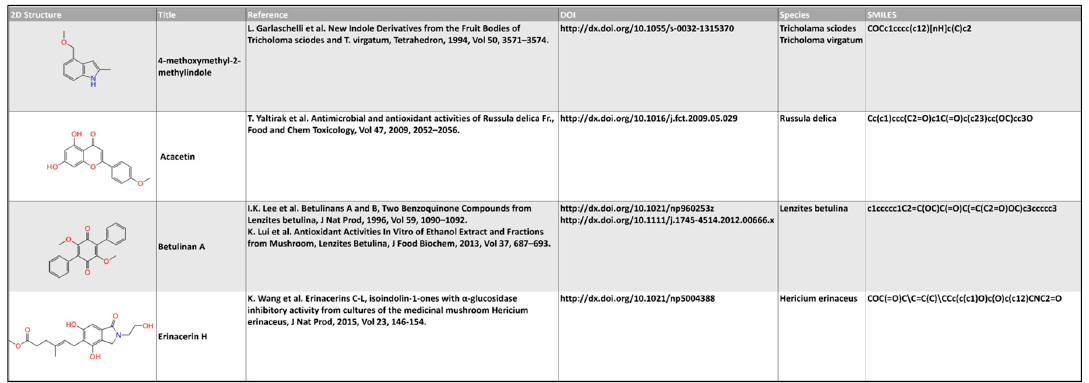
Figure 11. Example of a screenshot in the implementation of the database fragment containing 2D Structure, Title, reference, DOI, species and SMILE of the compounds extracted from the mushrooms.